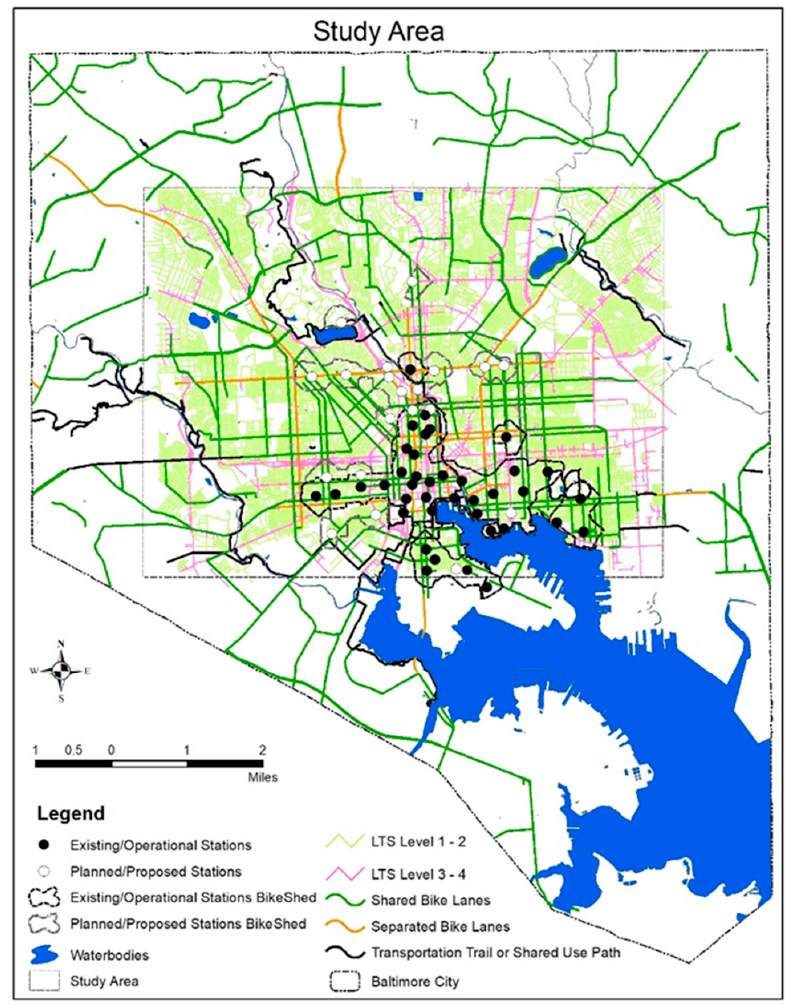
Figure 1. Map of Baltimore City bicycle infrastructure and study